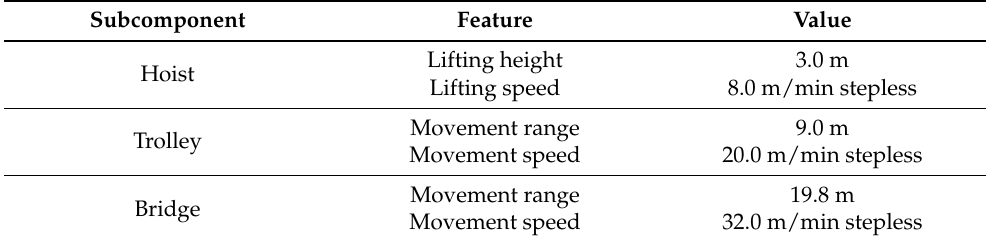
Figure 2. The description of the overhead crane. Table 1. Hardware of the crane: subsystems and their basic functional